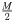
Gremlin-trained Potts models accurately predict 3D RNA contacts.Top M2 predicted 3D contacts from Gremlin-trained Potts models (cyan) against annotated nested base pairs (gray) and annotated tertiary contacts/pseudoknotted positions (pink) from the tRNA (A), Twister type P1 ribozyme (B), and SAM riboswitch (C) training alignments. For tRNA, annotated tertiary contacts are from a yeast tRNA-phe crystal structure [48]. A non-structural covariation between the tRNA discriminator base and the middle nucleotide in the anticodon (caused by aminoacyl-tRNA synthetase recognition preferences, not conserved base-pairing) is noted in orange [49].